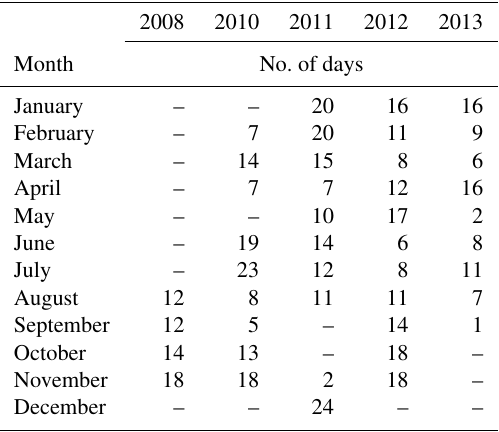
Table 2. Number of days in which magnetometers and some GNSS receivers used were simultaneously operational.